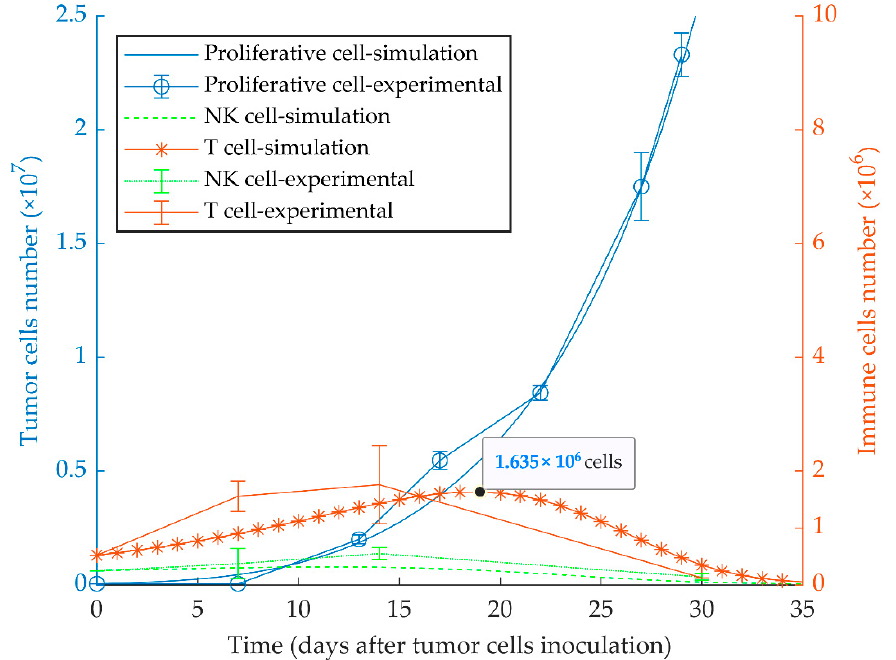
Figure 1. Mathematical simulation of proliferative tumor growth. By simulating the injection of 5 × 10 4 proliferative tumor cells (WT 4T1) in immunocompetent mice, the tumor overcomes the immune system, and grows exponentially to the lethal phase as in the experimental model. The left and right y -axes represent the number of tumor cells and immune cells, respectively. Experimental data are from Reference [51] and are represented as mean ± SEM.